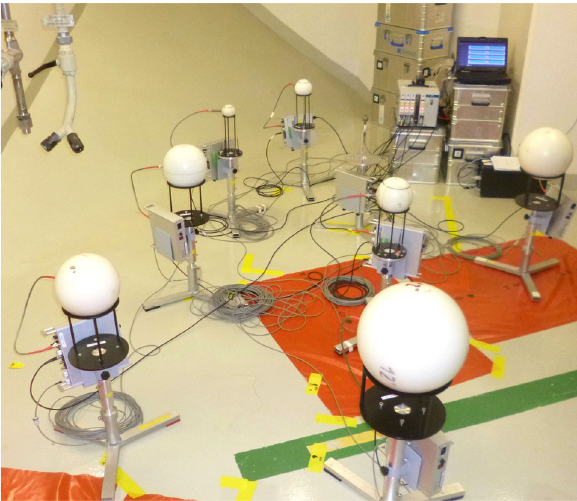
Fig. 11 ExperimentalarrangementusedfortheDS-1(reactorON)and DS-2 measurement (reactor OFF). The Bonner spheres were distributed around the central position of the future CONUS setup. The bare detec- tor is located at the central position